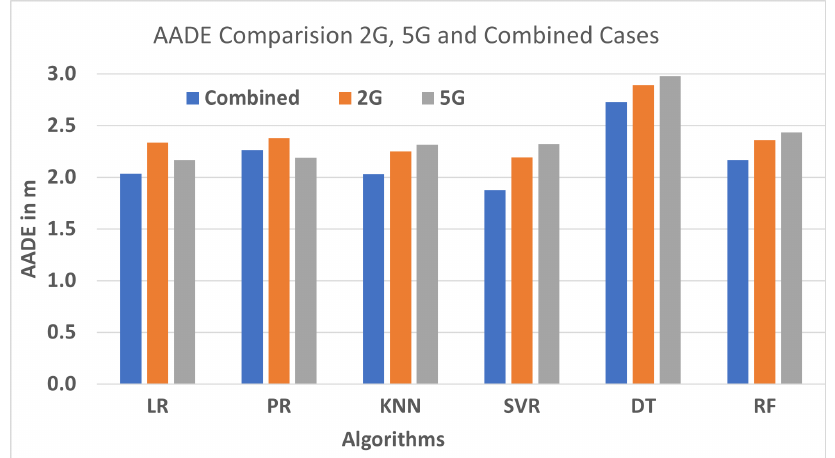
Figure 4. Average ADE (AADE) in meters for different algorithms for three cases.